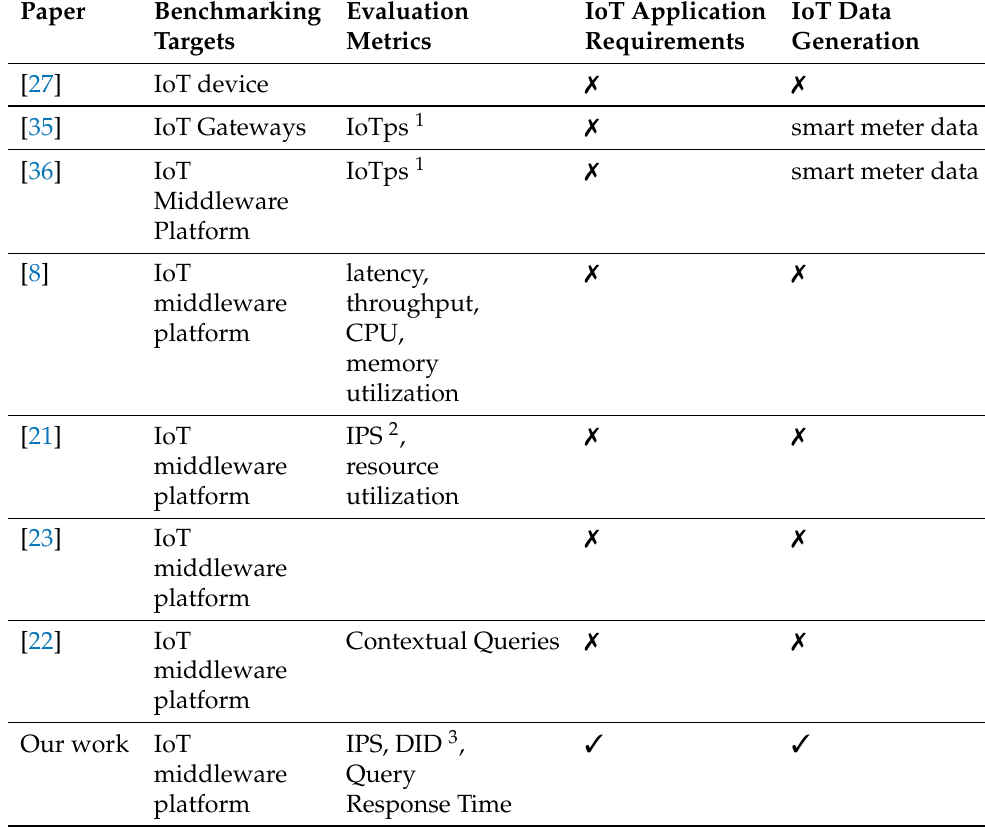
Table 1. Summary of existing IoT